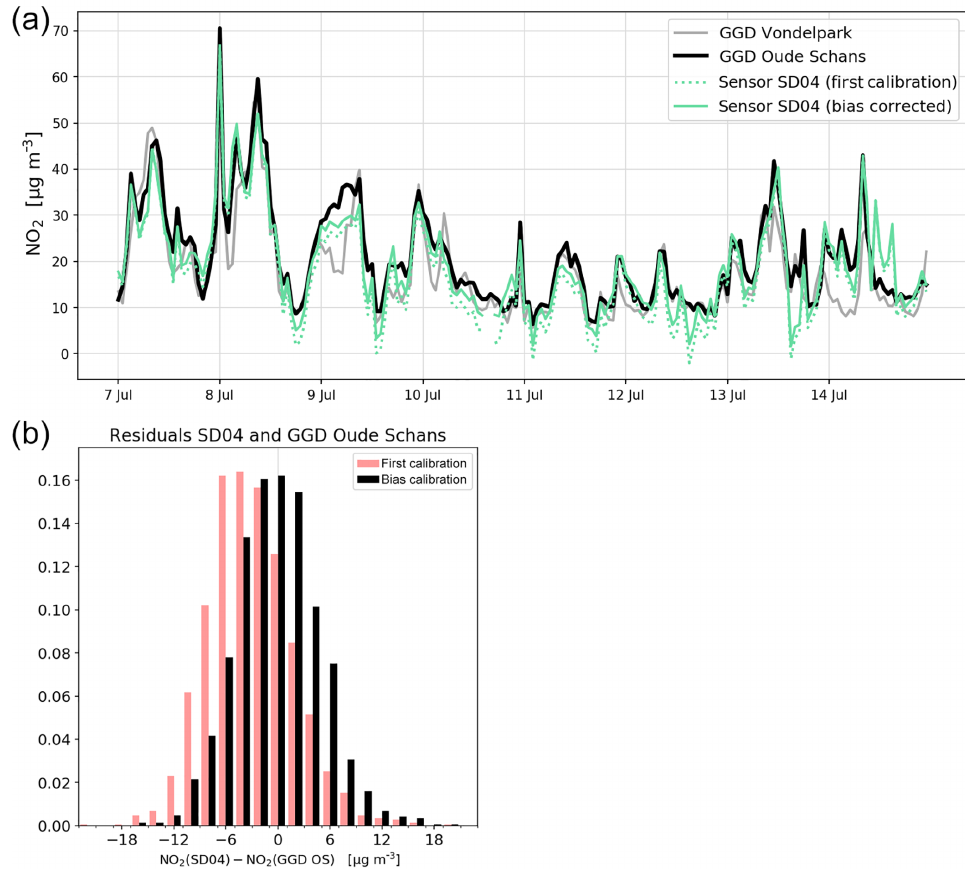
Figure 9. (a) Comparison of sensor SD04 NO 2 time series with the nearby Oude Schans station (8-day snapshot), and the effect of bias correction. For comparison, measurements of Vondelpark station are also shown. (b) Distribution of residuals of NO 2 measurements between sensor SD04 and Oude Schans station during the campaign period, with and without bias